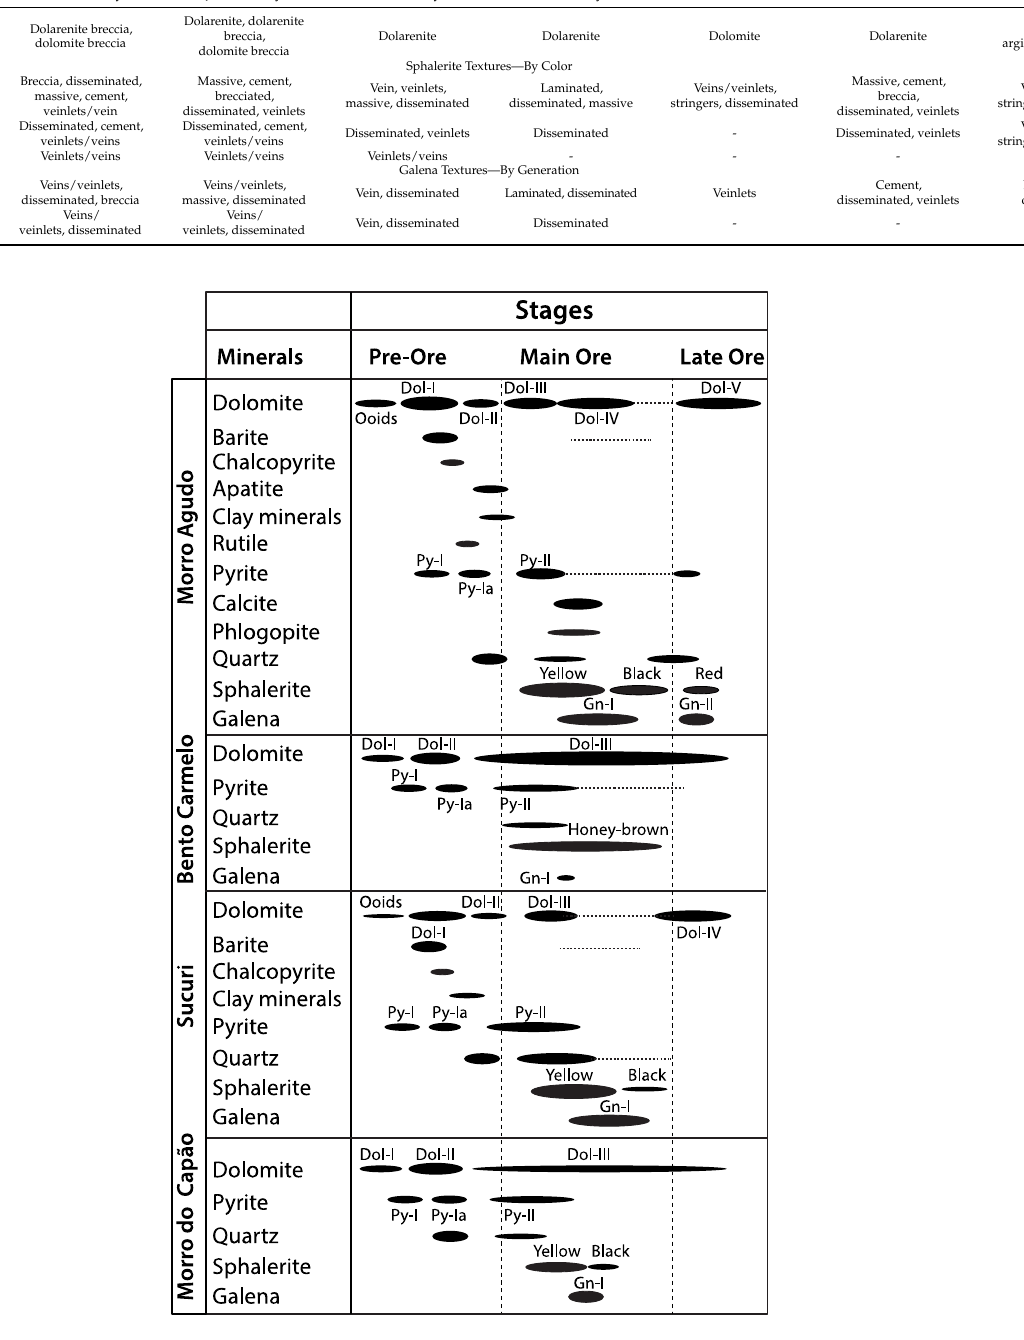
Figure 5. Simplified paragenetic sequence for the orebodies and occurrences within the Morro Agudo district (modified from Aldis et al. [15]).